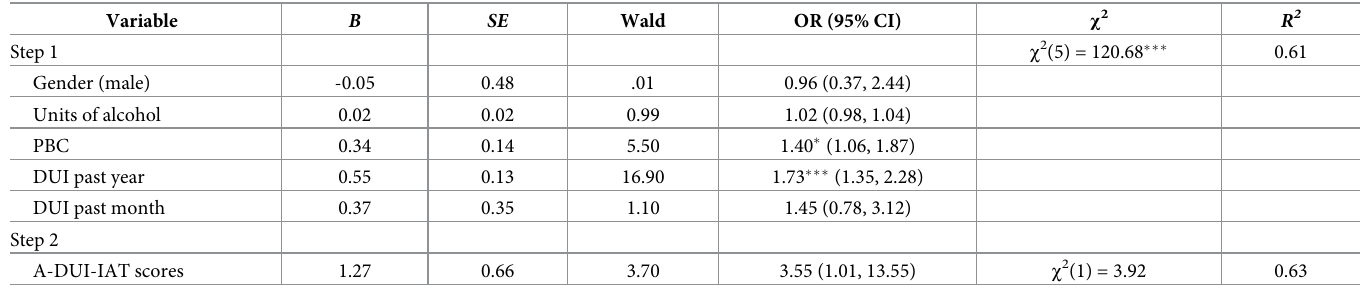
Table 5. Hierarchical logistic regression predicting prospective drunk driving (Study 2).